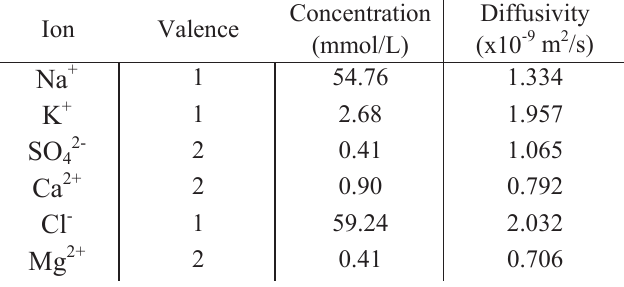
Table 3: The properties of the free ions assumed to be in the alginate/S-DMEM hydrogel. Composition due to 50% S-DMEM as given in [78]. Diffusivities from